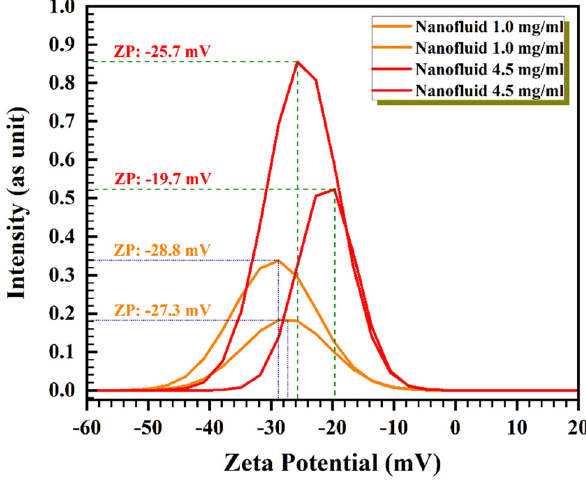
Figure 9: ZP pattern of graphene at mass concentrations of 1 and 4.5 mg/mL.